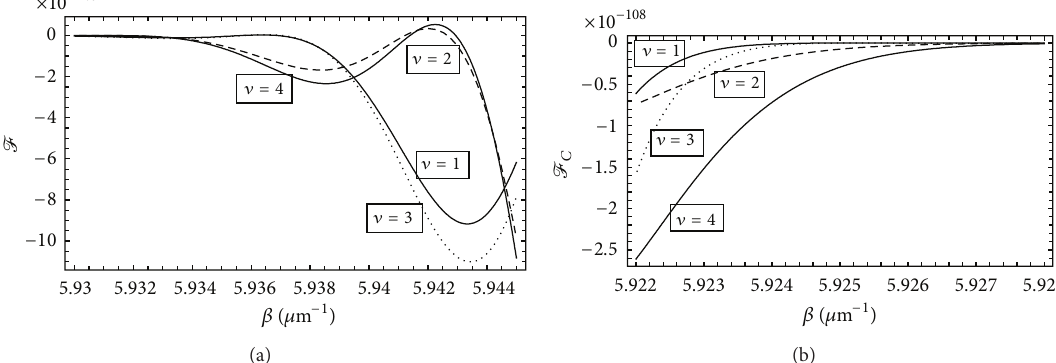
Figure 5: (a) Plot of the dispersion relation for the TE modes corresponding to 𝜓 = 90 ∘ . (b) Plot of the cutoff characteristics for the TE modes corresponding to 𝜓 = 90 ∘